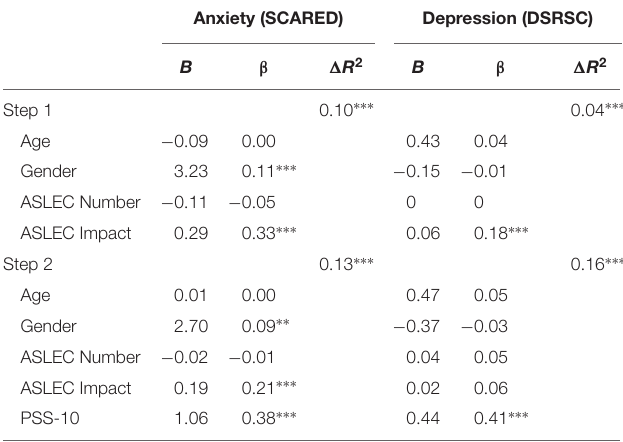
TABLE 4 | Hierarchical regression models for predicting anxiety and